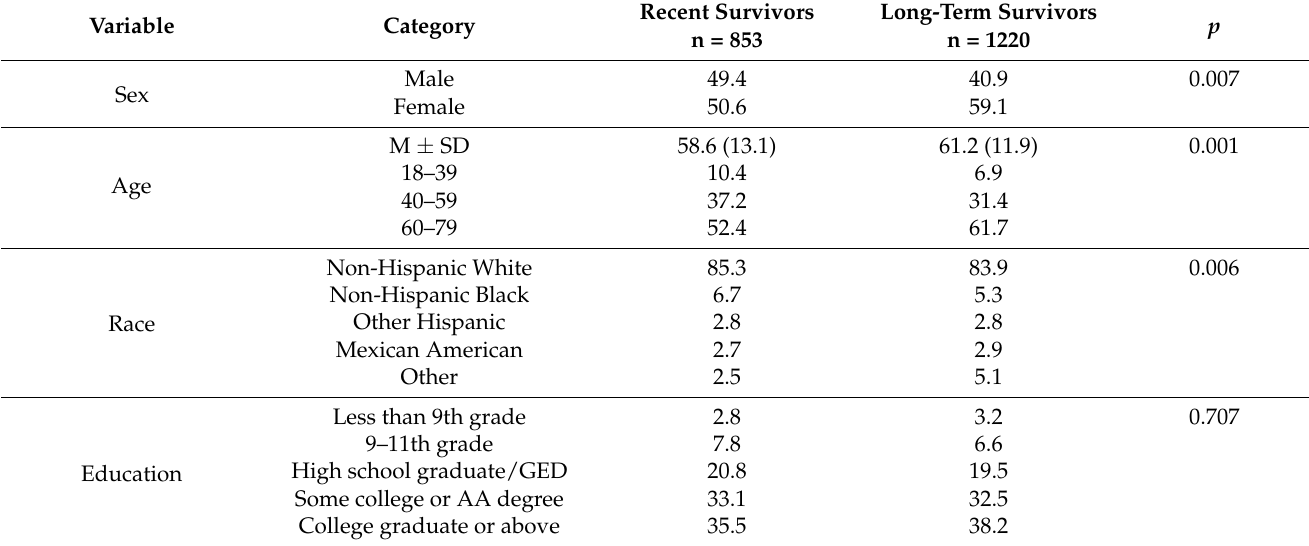
Table 1. Basic demographic and clinical characteristics of recent and long-term cancer survivors.